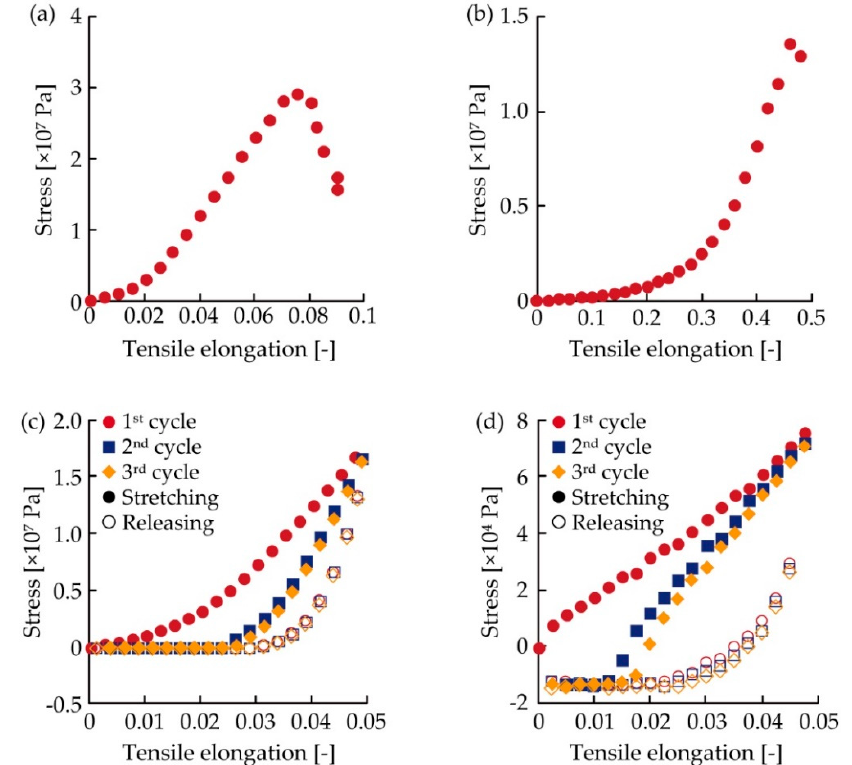
Figure A1. Mechanical property of a plain weave cotton under tensile deformation. ( a ) Horizontal and ( b ) diagonal weave under single tensile deformation. ( c ) Horizontal and ( d ) diagonal weave under tensile deformation of 3 cycles.